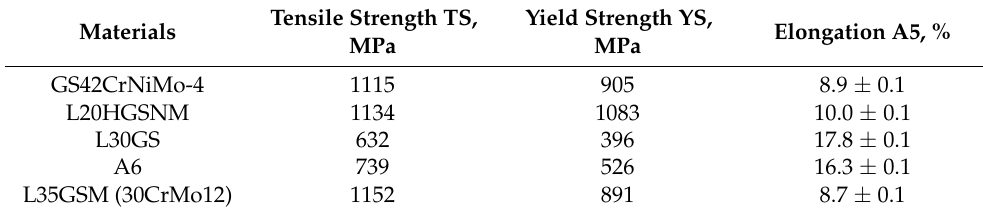
Table 1. Mechanical properties of the tested cast steel.